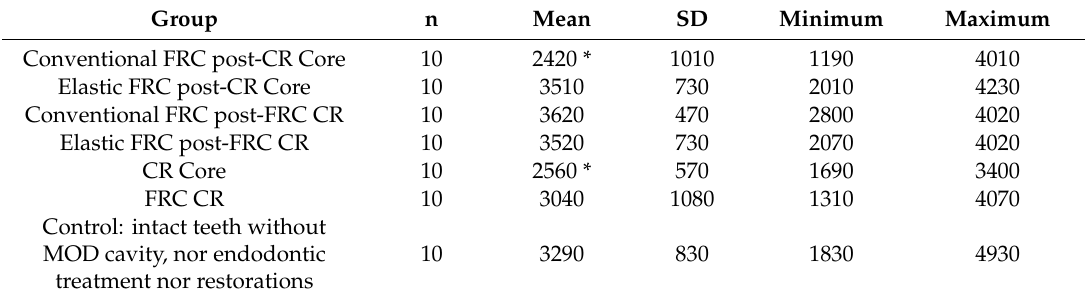
Table 3. Descriptive statistics of the fracture resistance values (N) of the study groups after bending test. * p value < 0.05. (One-way ANOVA test for comparing the means between multiple groups).